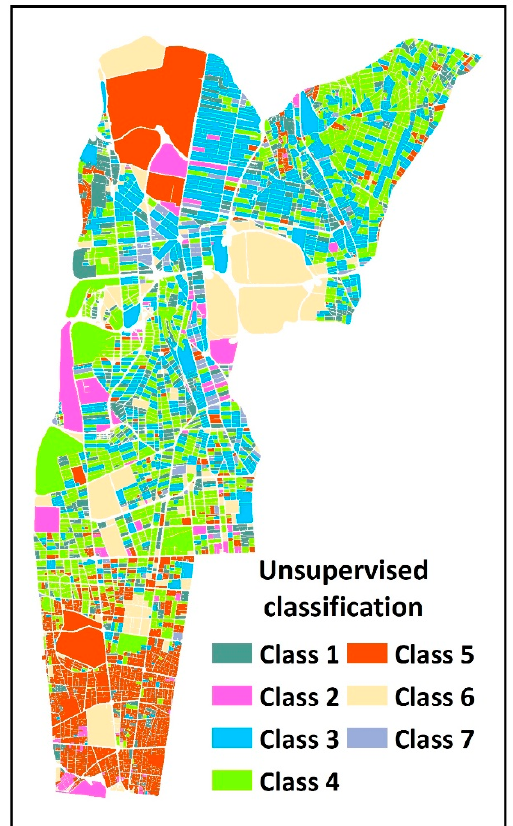
Figure 13. The output of GetSpatialClassification operations applied to study area.